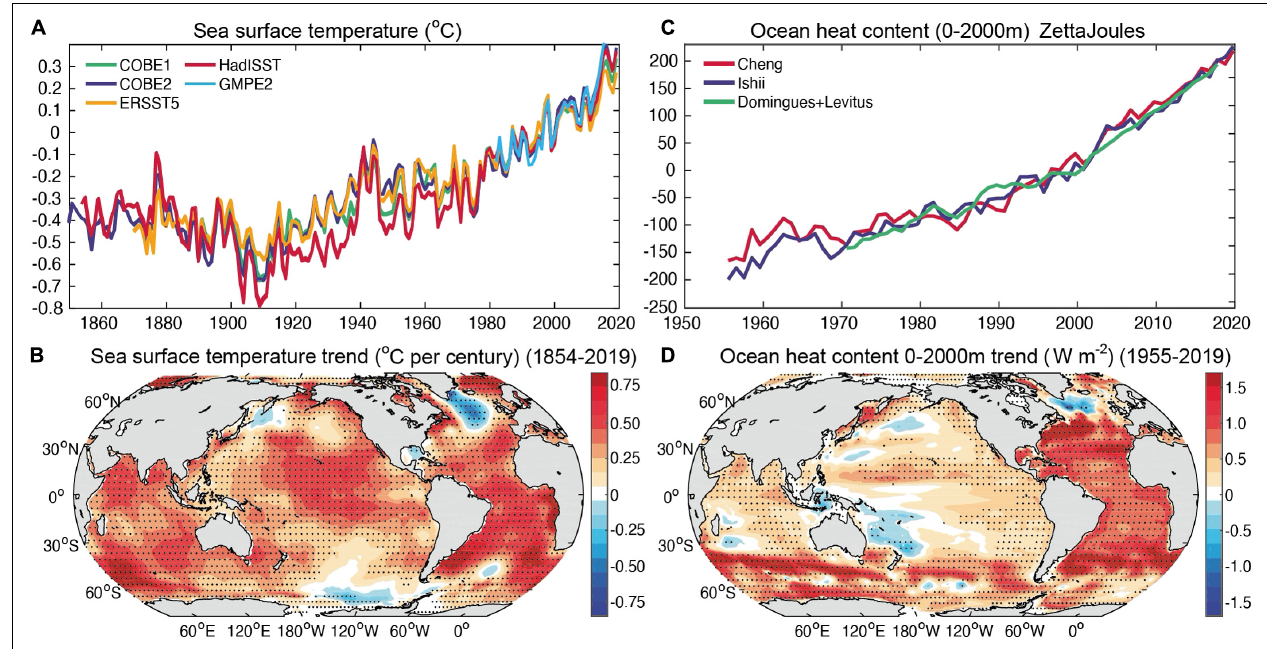
FIGURE 1 | (A) Global mean SST time series from1850 to 2019 ( ◦ C). Five datasets are used, including: COBE1, COBE2, ERSST5, HadISST, and GMPE. (B) Spatial distribution of the long-term SST trend from 1854 to 2019 for ERSST data ( ◦ C per century). (C) Global ocean heat content changes for the upper 2,000 m, three time series are provided (Domingues et al., 2008; Levitus et al., 2012; Cheng et al., 2017; Ishii et al., 2017). The Domingues estimate (0–700 m) is combined with the Levitus estimate (700–2,000 m) to produce a 0–2,000 m time series, according to IPCC (Rhein et al., 2013). The energy unit is the ZettaJoule (10 21 Joules). (D) Spatial distribution of long-term ocean heat content trend (0–2000m) (W m − 2 ) for Cheng et al. (2017) data. All data are annual mean time series and use a 1981–2010 baseline. Black dots (in b and d) indicate grid boxes where trends are significant at a 90% confidence